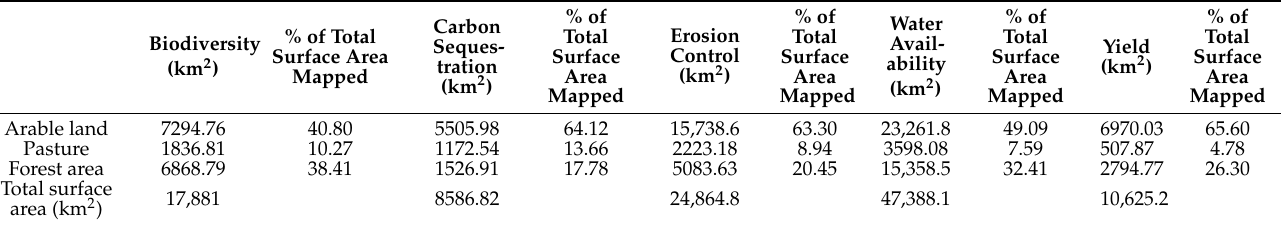
Figure 6. Demand for Erosion Control and Land Use in MOL. Table 6. Mapped area for all ES per land use in